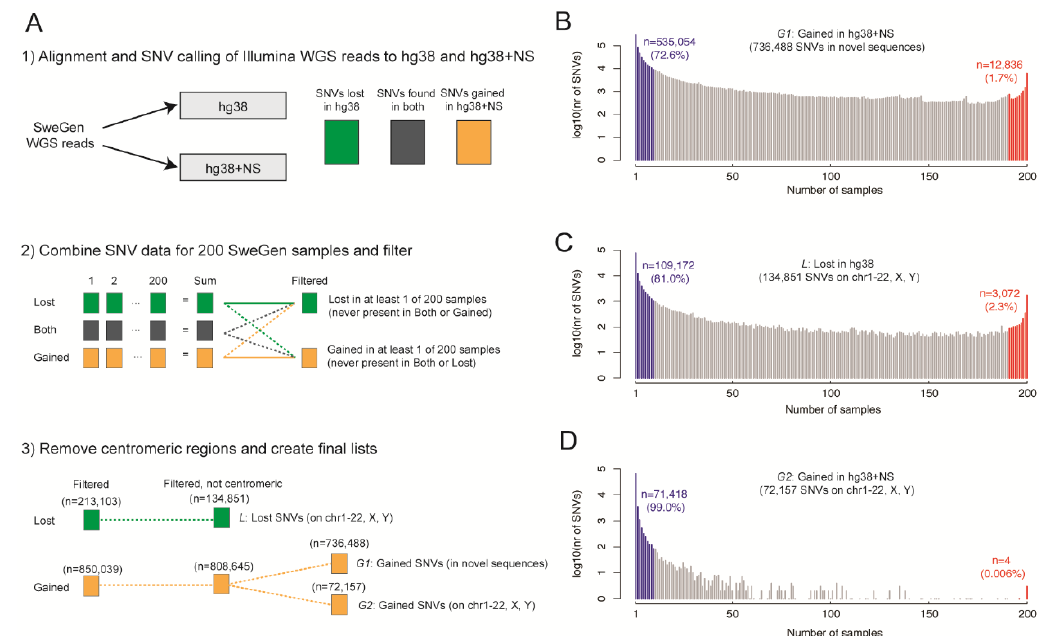
Figure 4. Re-analysis of Illumina WGS data using a Swedish human reference. ( A ) Overview of our method to evaluate the effect of NS on SNV calls from Swedish Illumina WGS data. In the first step, reads from 200 SweGen samples [1] were aligned both to hg38 and to an extended reference (hg38+NS), where 17.3 Mb of NS detected in Swe1 and Swe2 were appended to hg38. In step 2, single nucleotide variants (SNVs) for each of the samples were sorted into three groups: (i) SNVs found only in hg38, but not in hg38+NS (named Lost, in green); (ii) SNVs found both in hg38 and hg38+NS (‘Both’, in grey); and (iii) SNVs found only in hg38+NS, but not in hg38 (Gained, in orange). After such SNV tables were generated for all 200 individuals, a summary file was created for the Lost and Gained group. The Lost SNVs were not allowed to be detected in any of the Gained or Both files. A similar filtering was also performed for the Gained group. In step 3, we further filtered the SNV lists by removing all centromeric regions (from file centromeres_UCSC_hg38.txt). The resulting Gained SNVs were separated into